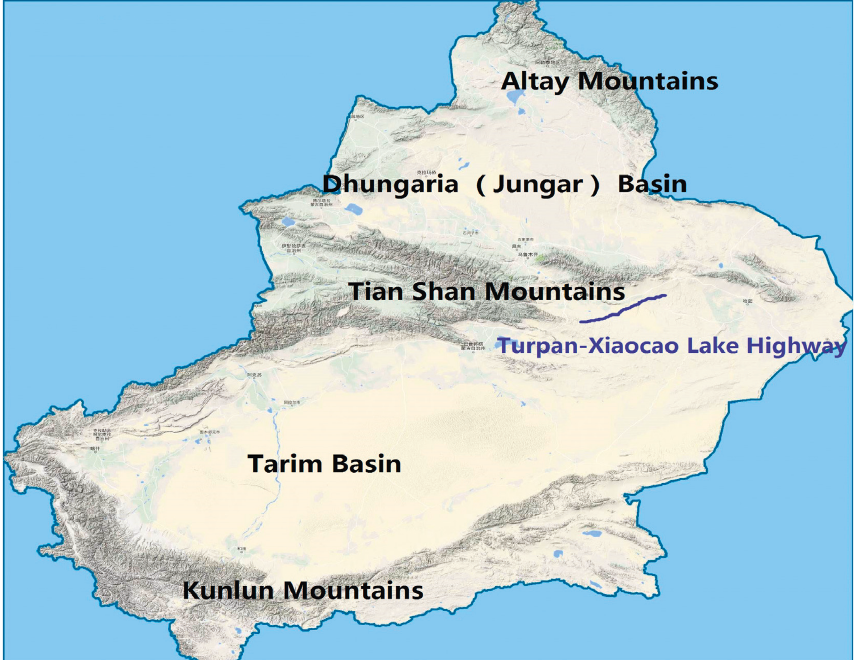
Figure 2: Location of the Turpan-Xiaocao Lake Highway. Source: website of the Xinjiang Bureau of Surveying, Mapping and Geoinformation.